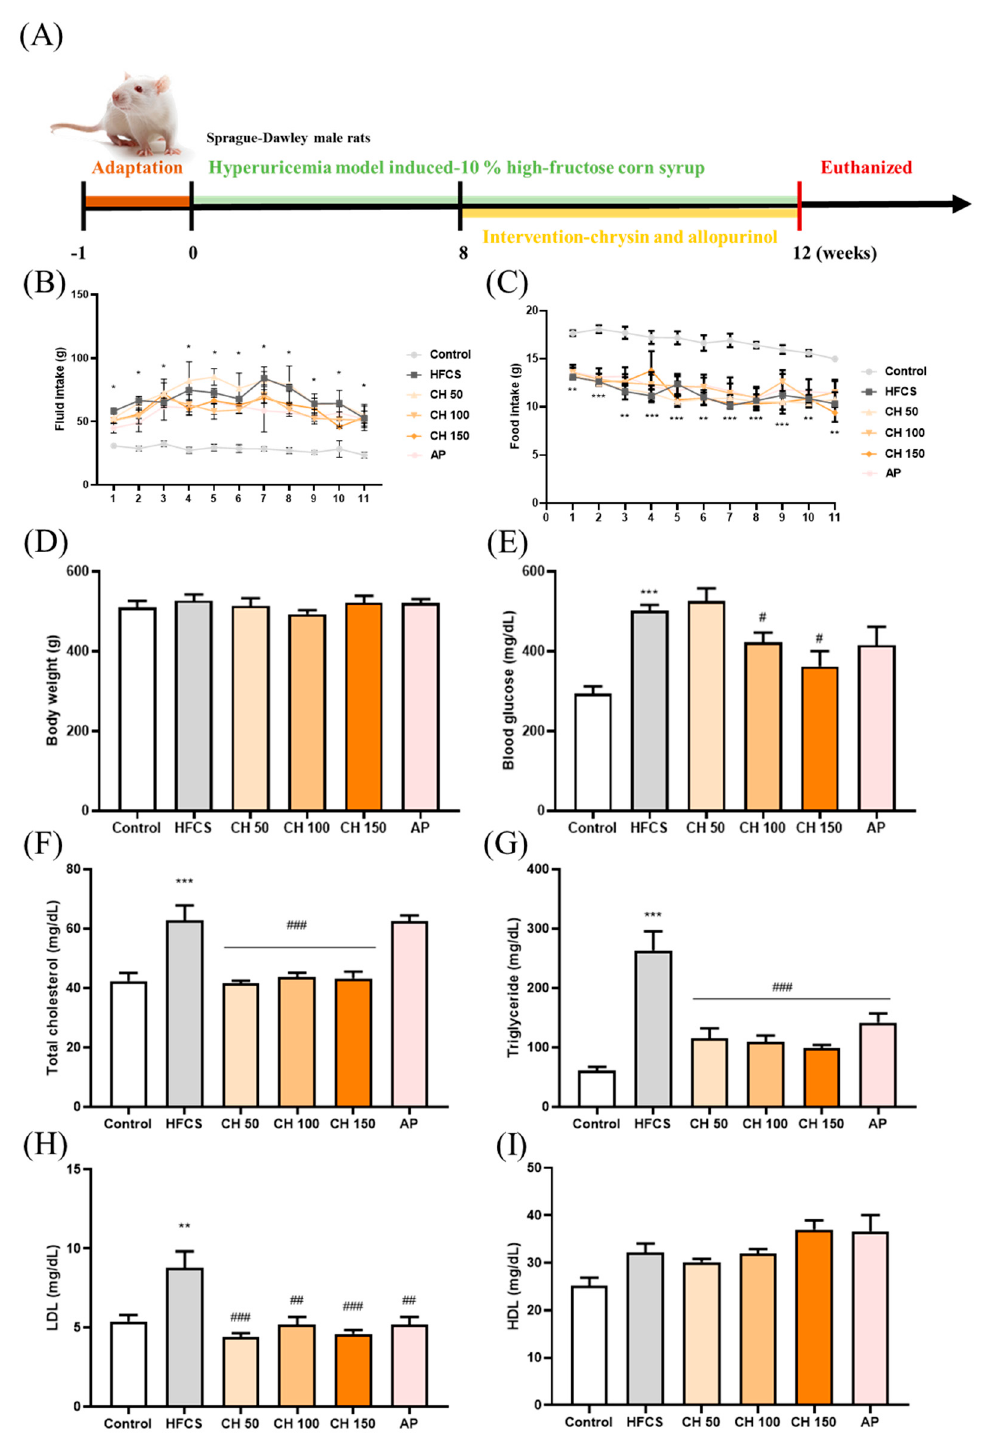
Figure 1. Effects of chrysin on food intake, fluid intake, body weight, serum glucose, and lipid profile. ( A ) Experimental flow chart, ( B ) fluid intake, ( C ) food intake, ( D ) body weight, ( E ) blood glucose, ( F ) total cholesterol, ( G ) triglycerides, ( H ) LDL, and ( I ) HDL level. C: control; HFCS: high-fructose corn syrup group (10% high-fructose corn syrup solution); AP: allopurinol (10 mg/kg BW); CH 50: chrysin (50 mg/kg bw); CH 100: chrysin (100 mg/kg bw); CH 150: chrysin (150 mg/kg bw). Data are represented as mean ± SEM. ( n = 4–6 per group). * p < 0.05, ** p < 0.01, *** p < 0.001 versus the control group. # p < 0.05, ## p < 0.01, ### p < 0.001 versus the HFCS group.